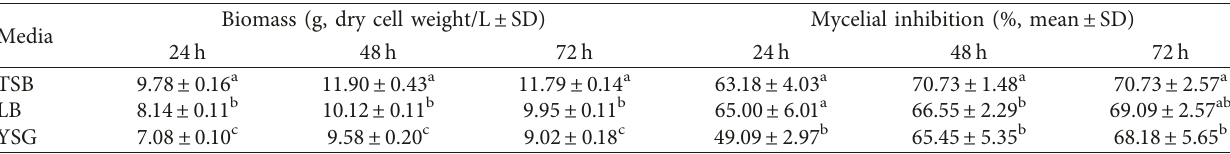
Table 5: Effect of different media on biomass and antifungal activity of X. stockiae PB09 against Phytophthora sp. after cultivation by using shake flasks at different periods of time.